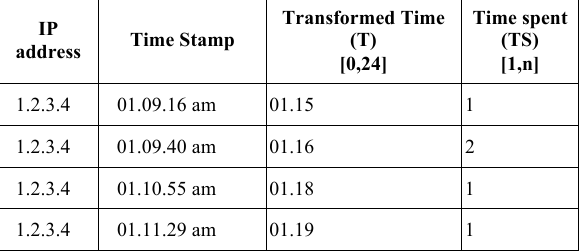
TABLE I. T YPE S IZES FOR R ANGE TRANSFORMED T